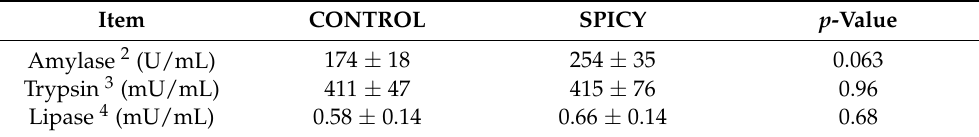
Table 5. Effects of experimental diets on the activity of pancreatic enzymes in broilers at 21 d of age 1